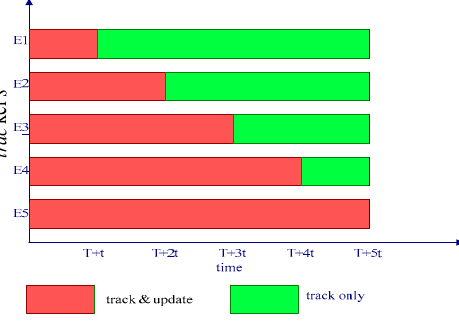
Figure 1. Update Policy of MT.